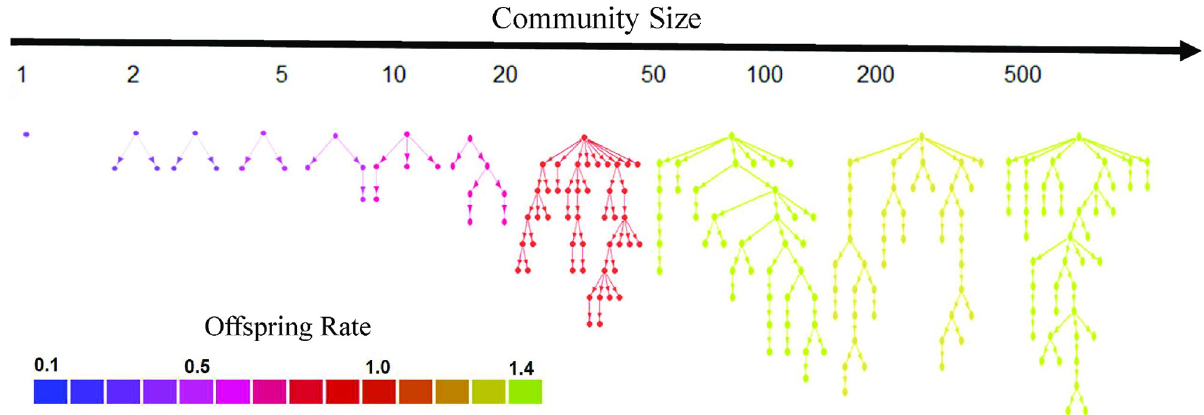
Fig 3. A schematic of selected discussion trees ordered by community size. The nodes mark response posts and the root is the initial “seed” post. Links between nodes are the association of post and reply. The illustrated trees are color-coded according to the mean rate of replies to messages (mean offspring rate) within each community size